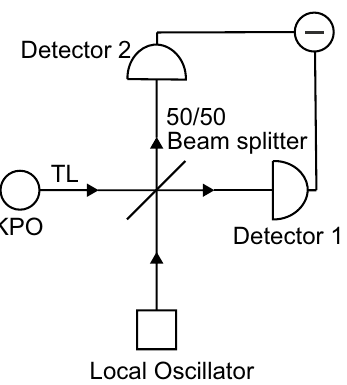
Figure 1. Schematic illustration of homodyne detection of a KPO attached to a transmission line (TL). The signal from the KPO and the classical coherent light from a local oscillator passing through a beam splitter are detected by detector 1 and 2. Information about the KPO is obtained after subtraction of the photocurrents at the detector 1 and 2 (Circle with a horizontal